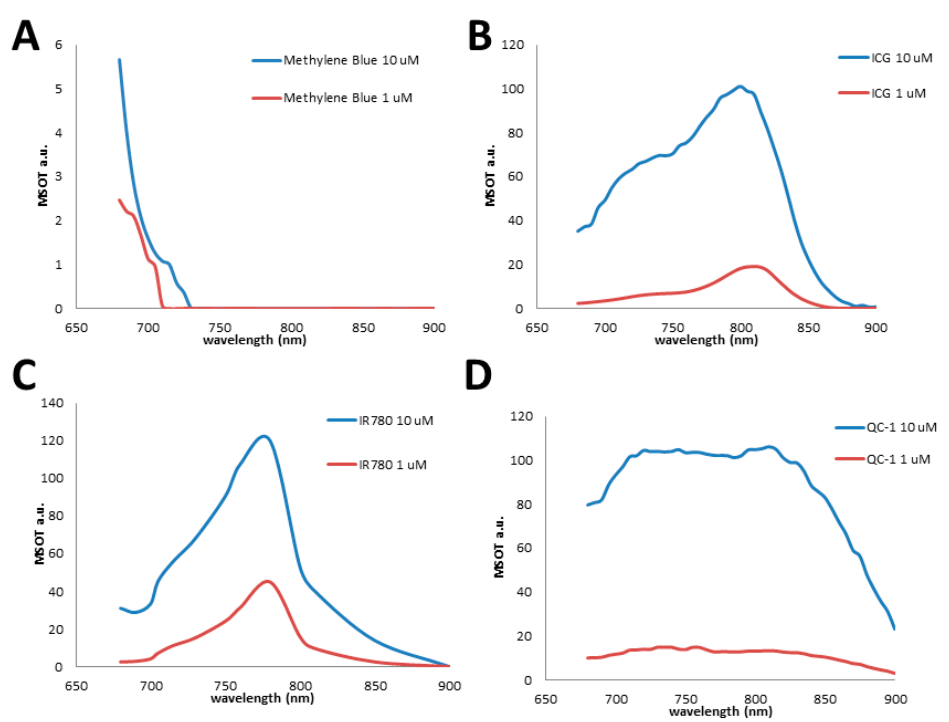
Figure 16. Optoacoustic spectral shapes of four representative dyes were evaluated at 1 µ M (red line) and 10 µ M (blue line) in tissue mimicking phantoms. Samples were measured at each 5 nm using an InVision 512-echo. ( A ) Methylene blue, ( B ) Indocyanine Green, ( C ) IR 780 iodide, ( D ) IRDye QC-1.